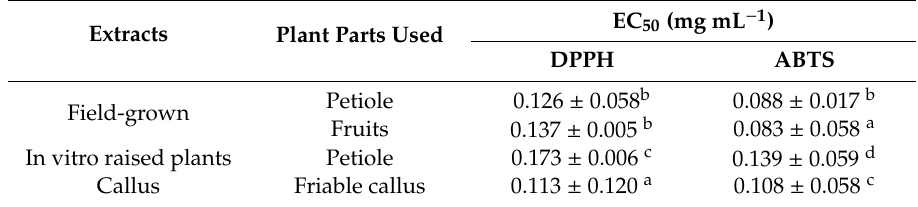
Table 8. Antioxidant activity of the field-grown plant parts, in vitro propagated and in vitro-derived callus of A.